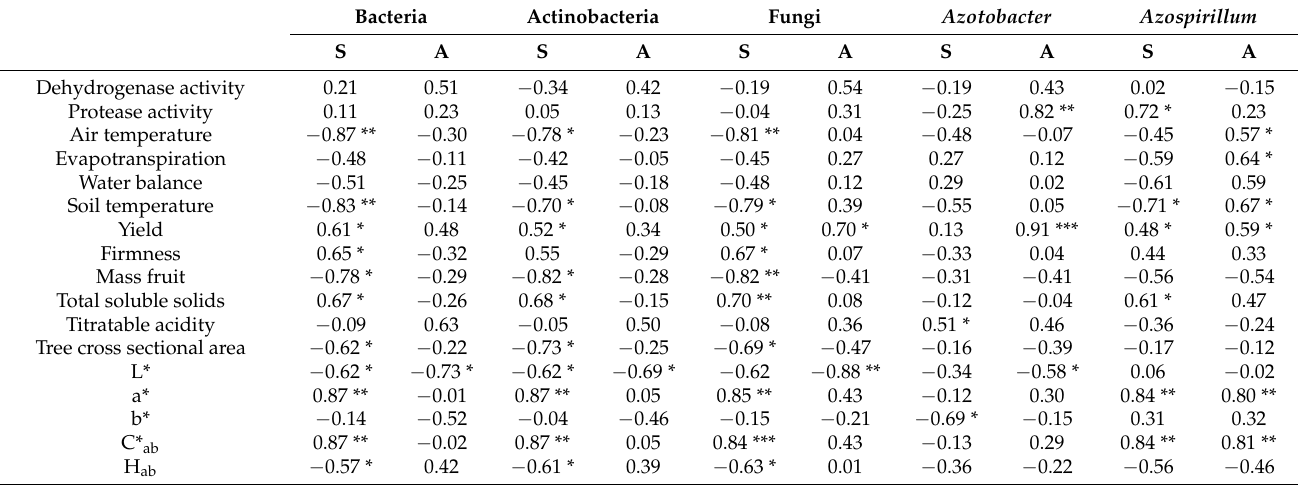
Table 8. Value of the linear correlation coefficient depending on the abundance of soil microorganisms. Bacteria Actinobacteria